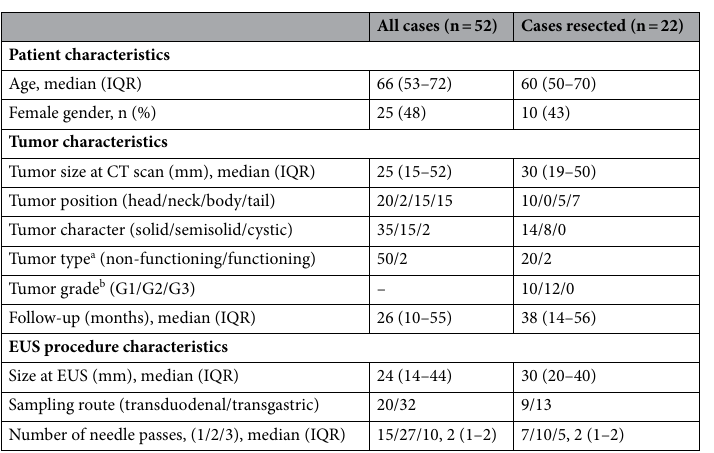
Table 1. The study baseline characteristics. a Tumor type was based on clinical symptoms caused by tumor hormone production. Both patients with a functioning tumor had an insulinoma. b Based upon the Ki-67 Index calculated in the resection specimens (n =